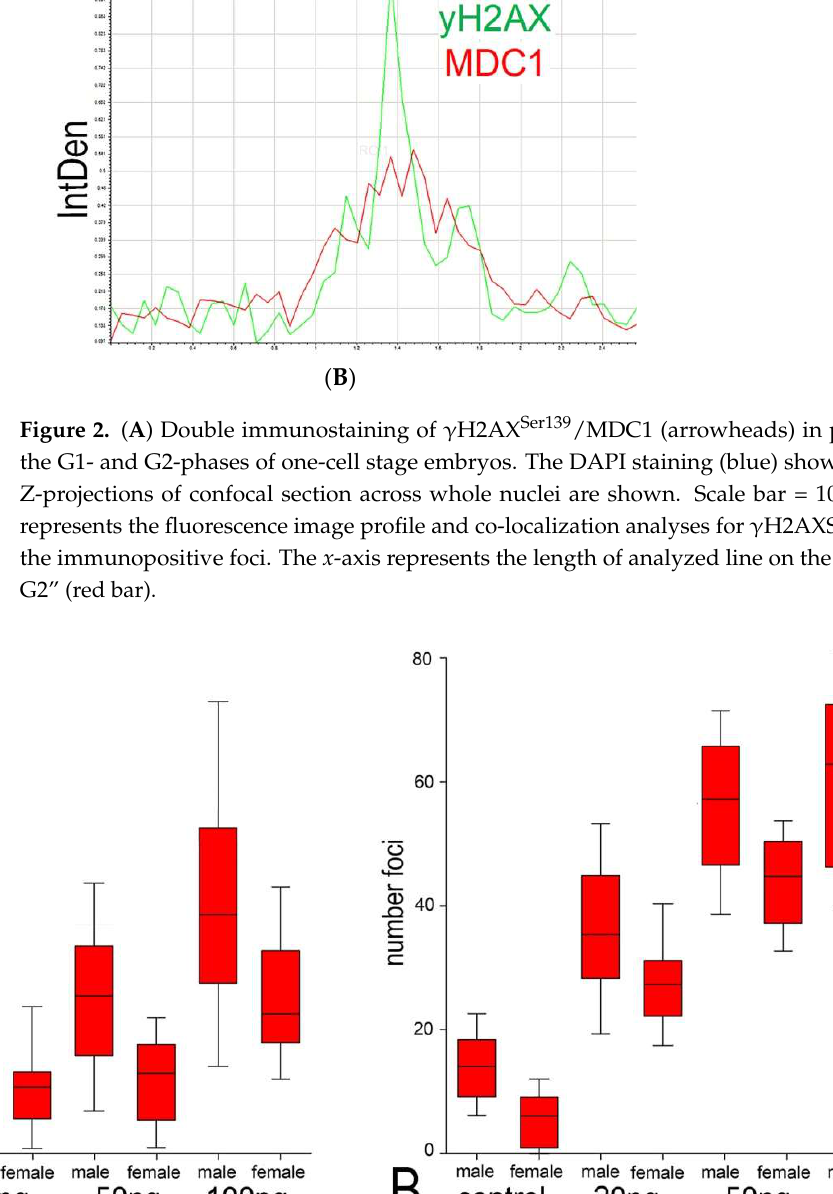
Figure 3. Quantification of γH2AX Ser139 / MDC1 immunopositive foci in the male or female pronuclei of control and NCS-treated one-cell embryos analyzed in the G1-phase ( A ) and G2-phase ( B ). The values show the average number of foci in the one-cell embryos of each experimental group. At the time interval of 44 h post hCG administration, 92% of the control embryos completed their first cleavage. Such embryos displayed the two-cell stage. At the same time point, approximately two-thirds (70%) of the embryos treated with 20 ng/mL NCS completed their first mitosis, and the other (30%) were still at the one-cell stage. In higher concentration of NCS (50 or 100 ng/mL), 38/37% were cleaved into the two-cell stage and 62/63% were still at the one-cell